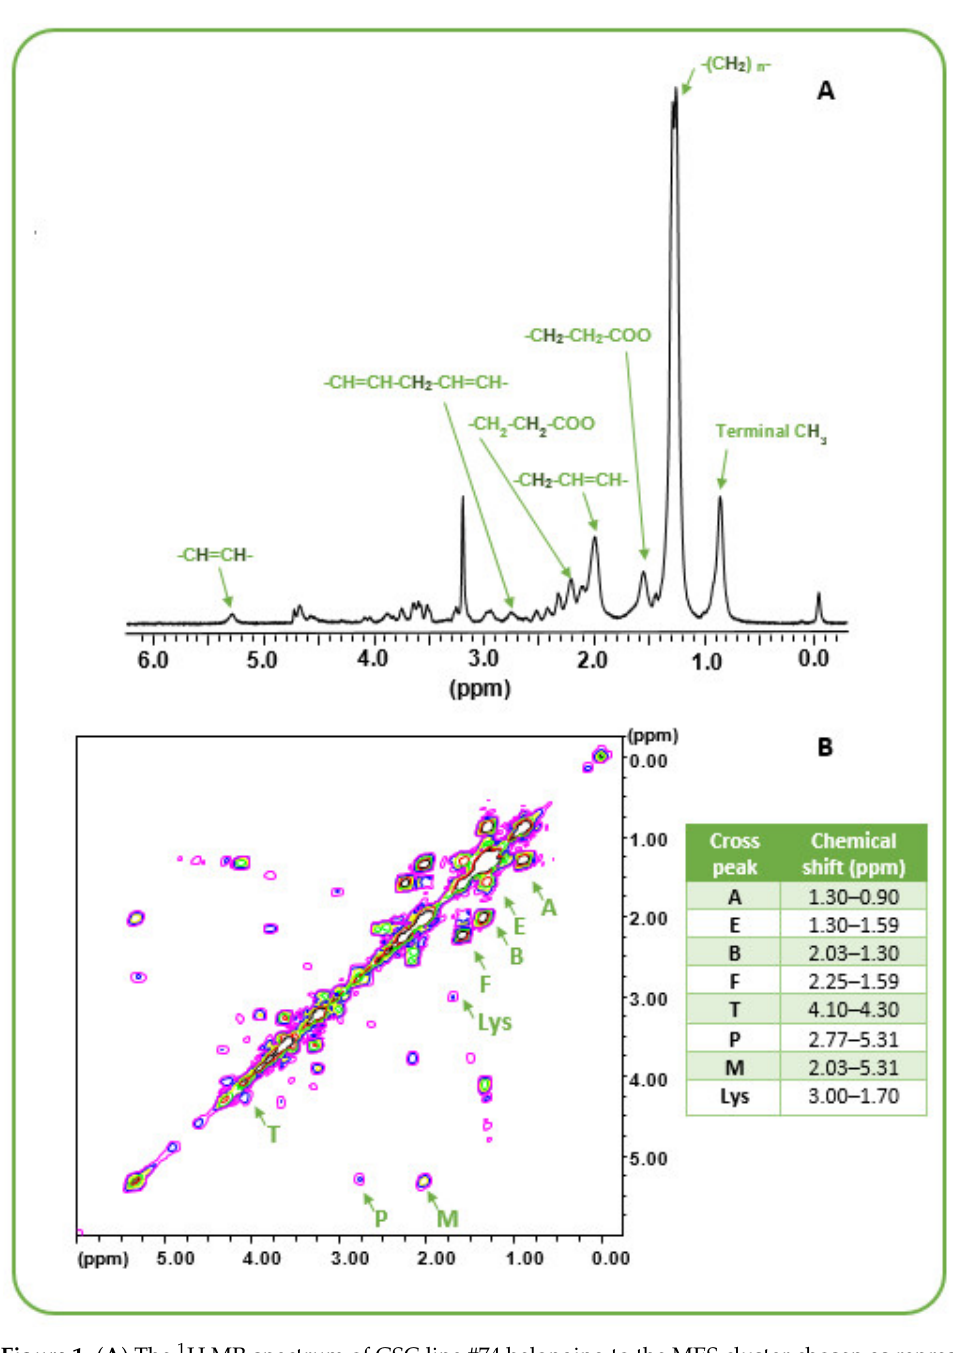
Figure 1. ( A ) The 1 H MR spectrum of GSC line #74 belonging to the MES cluster chosen as represen- tative of the analyzed cell lines. Signals of interest from the different chemical groups in FA chains are labeled according to Peterson et al. 2020 [38]. ( B ) The 2D MR COSY spectrum of line #74. Main lipid cross peaks analyzed in this study are labeled together with the lysine (Lys) cross peak used as an internal reference for the intensities. The Table reports the corresponding chemical shifts.